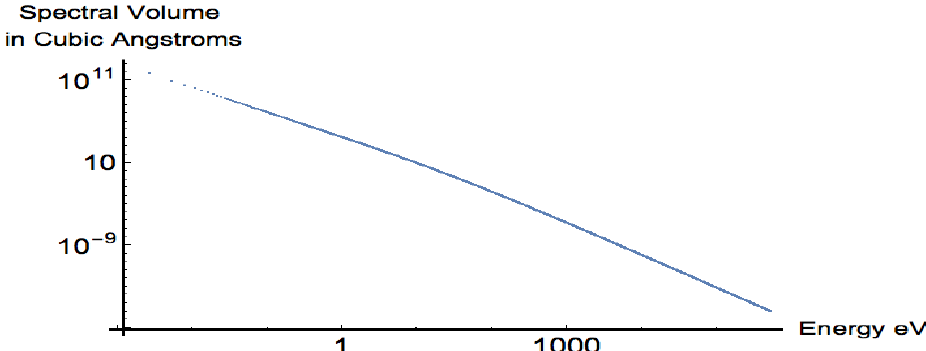
Figure 10. Log-log plot of the spectral volume V 1 ( E ) as a function of E . The spectral volume V 1 ( E ) contains the free field vacuum energy at energy value E that corresponds to the ground state shift spectral density at the same energy E .